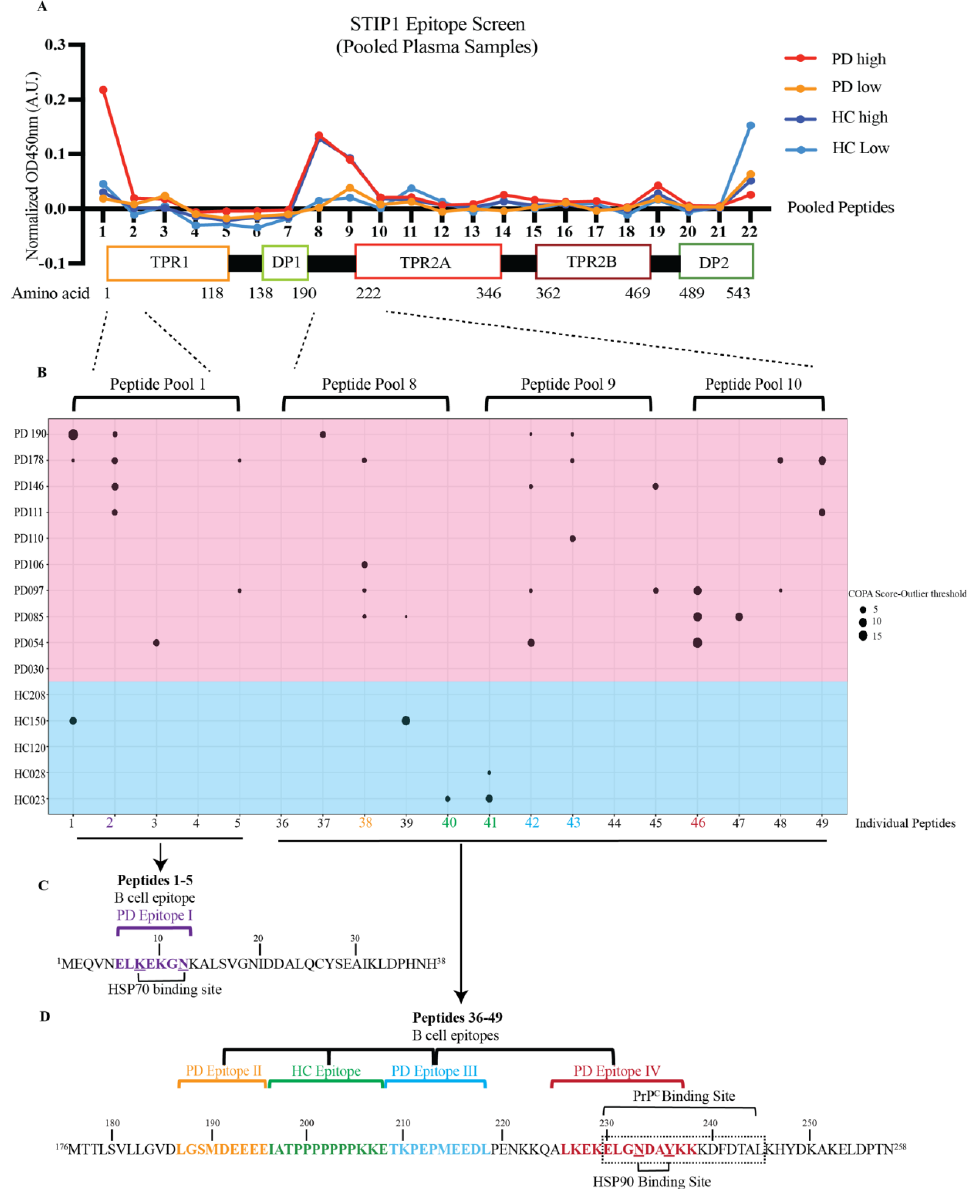
Figure 3. STIP1 autoantibody binding patterns in Parkinson’s disease patients and healthy controls. ( A ) A 22-pooled peptide-based ELISA with each pool containing 5 peptides was performed. Pooled plasma samples of the healthy controls (HC) and Parkinson’s disease (PD) patients according to the levels of the STIP1 autoantibodies were made and screened against the pooled peptides. A linear representation of STIP1 domains that coincide with the pooled peptides and their respective amino acid number is shown. ( B ) A COPA table highlighting the distribution of the STIP1 autoantibody reactivity against individual peptides within pool 1 (peptides 1–5), pool 8 (peptides 36–40), 9 (peptides 41–45), and 10 (peptides 46–49) using the healthy control (Blue background) and Parkinson’s disease (red background) samples with high autoantibodies. A positive signal was determined using the difference between the COPA score and the COPA threshold. The size of the circles revealed the distance between the COPA threshold and the COPA score. A bigger circle coincides with a higher reactivity against the peptide. Amino acid sequences of ( C ) peptides 1–5 and ( D ) peptides 36–49 are shown. The core B cell epitope of the four PD epitopes I, II, III, IV are coded in purple, orange, blue and red, respectively. The HC epitope is coded in green. The underlined amino acids represent regions that associate to the HSP70 and HSP90 binding sites while the amino acids that are boxed up highlight the PrP C binding